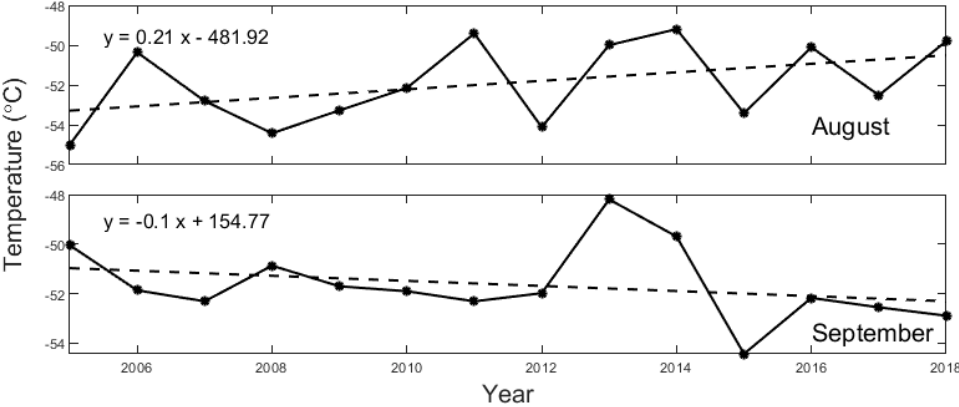
Figure 5. Averaged surface–10 km amsl temperature trends for August and September during 2005–2018 (the real lines). Linear fitted lines (the dashed lines) and the corresponding equations are also presented.